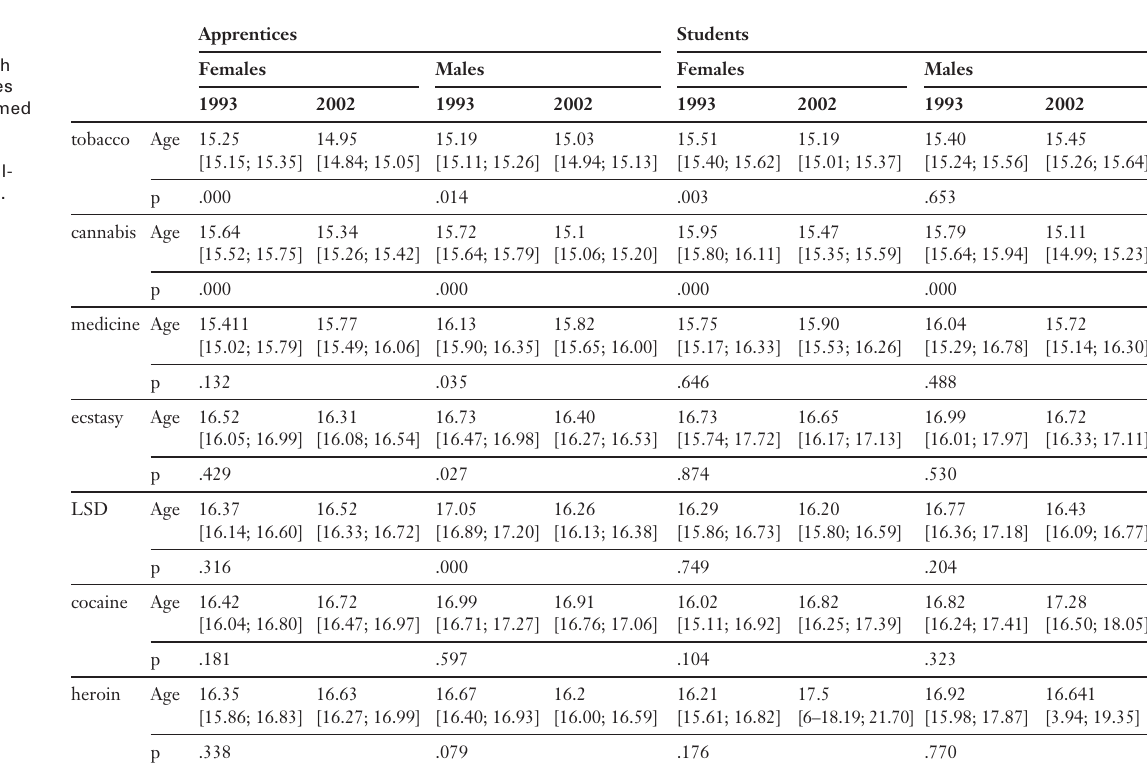
Table 3 Mean age at which various substances have been consumed for the first time, with confidence intervals and p val- ues (t-test